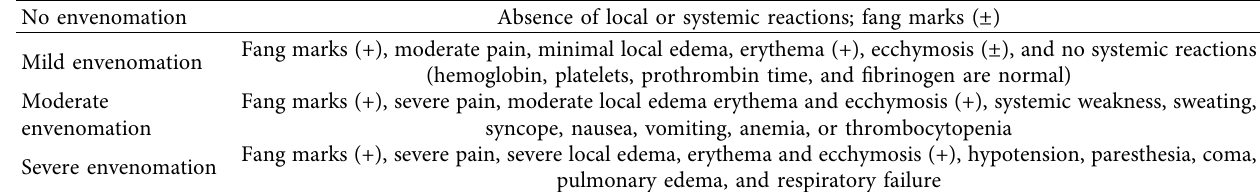
Table 1: Assessment of severity of envenomation. Absence of local or systemic reactions; fang marks ( ±